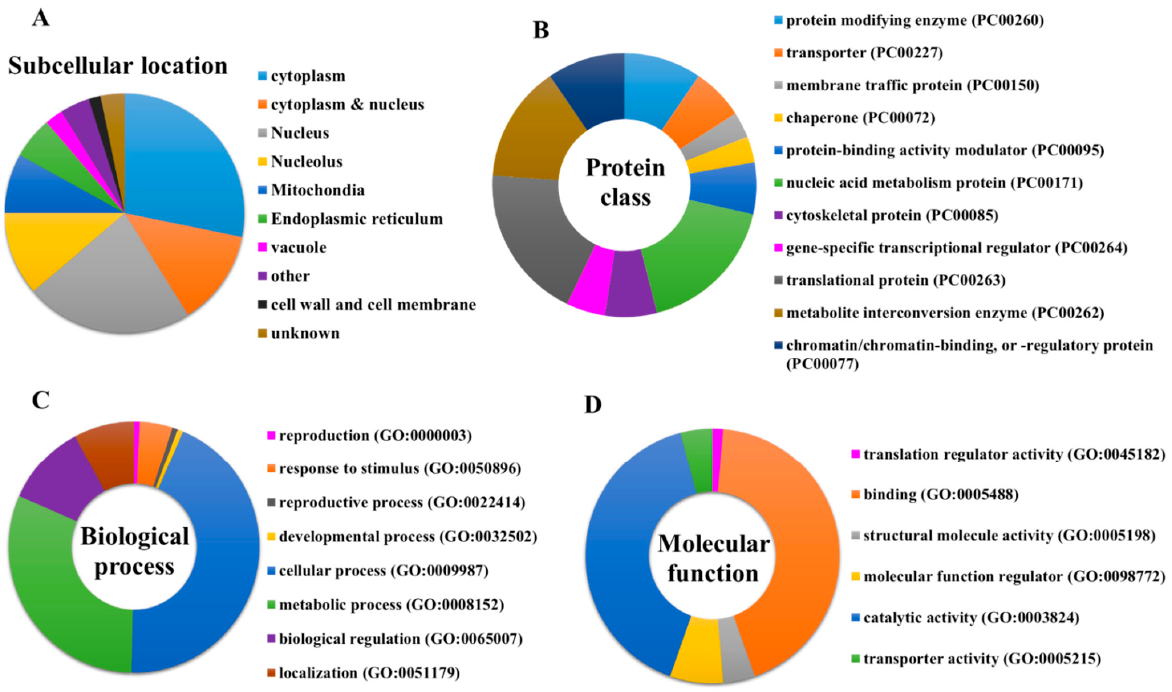
Figure 3. ( A ) Subcellular location of entire protein targets of penetratin. PANTHER classification system to classify the identified protein targets of penetratin into ( B ) protein class, ( C ) biological process, and ( D ) molecular function.